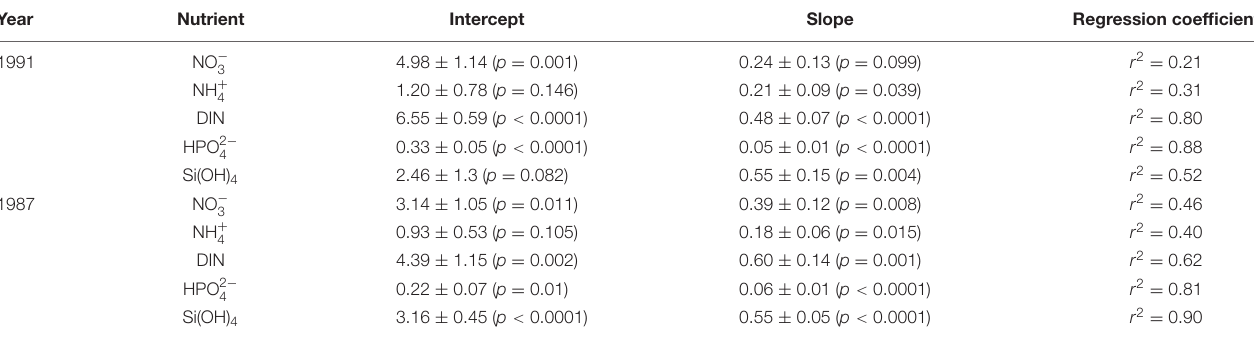
TABLE 2 | Linear regressions between the nutrient concentrations [nitrate (NO − 3 ); ammonium (NH + 4 ); total dissolved inorganic nitrogen (DIN); phosphate (HPO 2 − 4 ); silicate (Si(OH) 4 )] in the bottom layer and the time (half-month) from March to September in the middle of the Ría de Vigo in 1991 and in